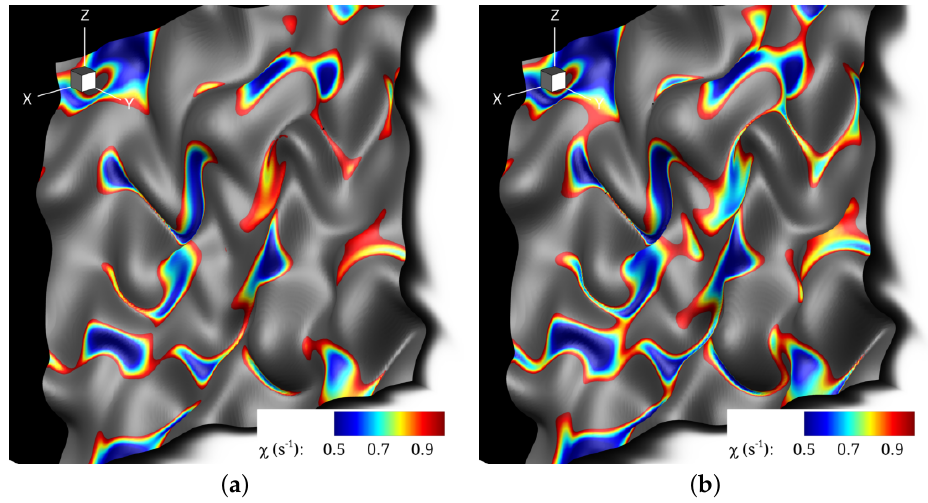
Figure 5. Iso-surface of the most reactive mixture fraction coloured by the scalar dissipation rate limited to χ = 1.0 s − 1 (the grey regions correspond to χ > 1.0 s − 1 ). The results obtained for the case HAT-200 in two time moments: ( a ) t = 0.9 ms; ( b ) t = 1.0